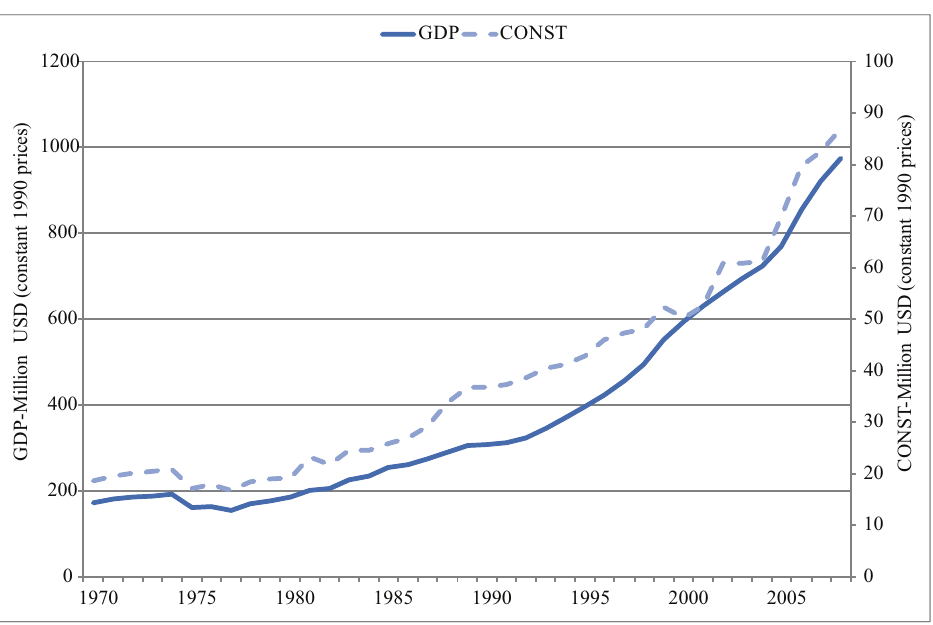
figure 4. evolution of GDP and construction valued added in Cape Verde (1970-2008)